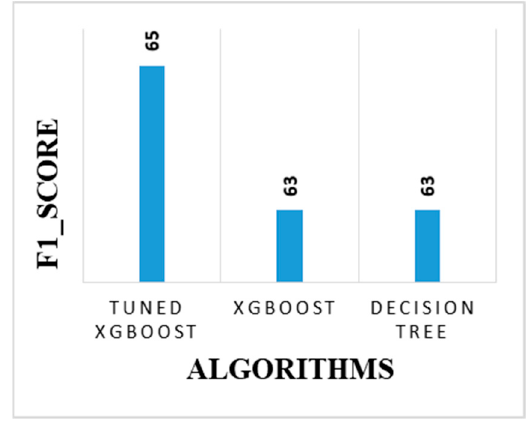
Figure 4. Comparison of F1_Score results.